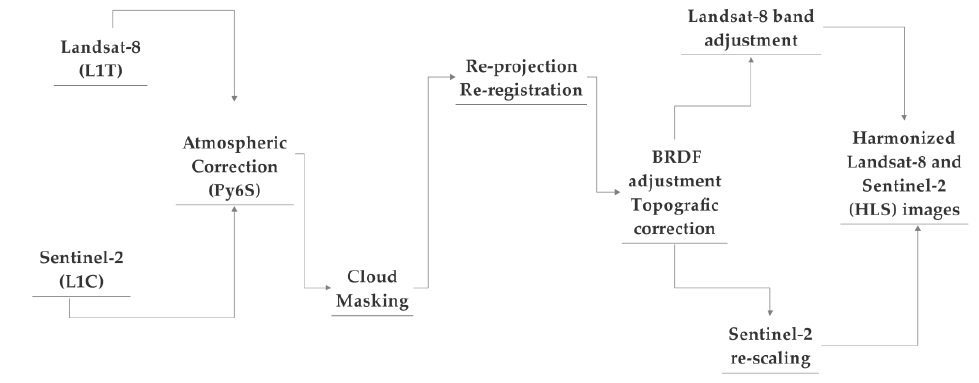
Figure 2. Overview of the HLS processing.